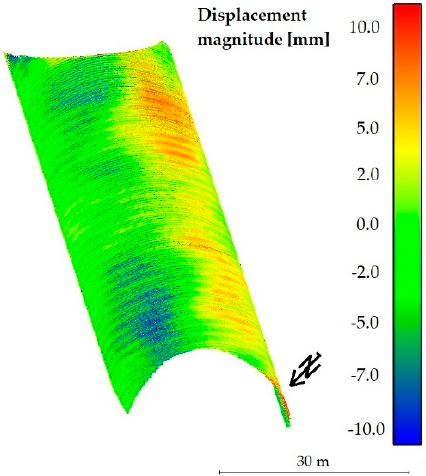
Figure 16. Periodic diagnostics of bridge deformations (displacement magnitude) measured one year after the final acceptance and inspection.